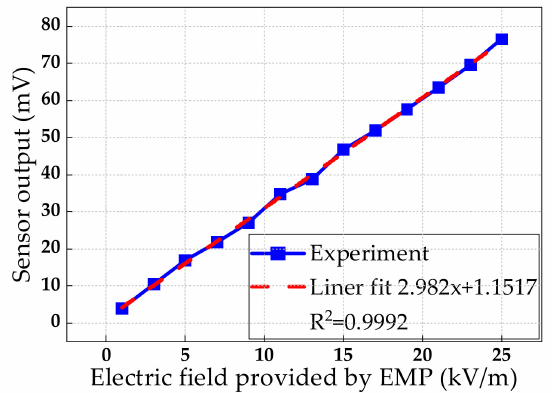
Figure 13. Sensor input/output